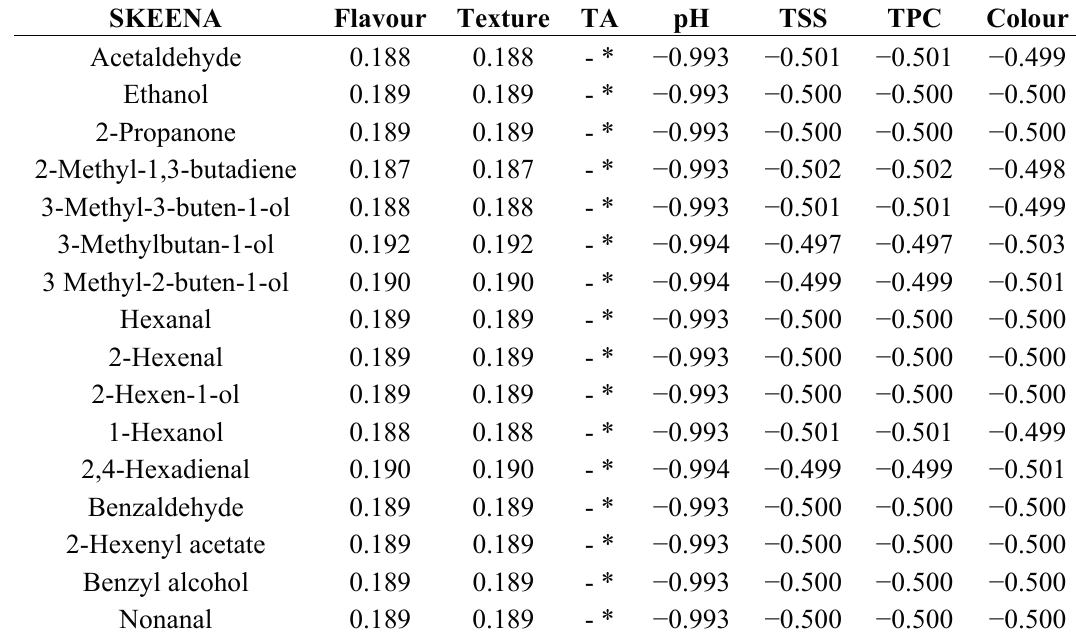
indicative however, of a very strong correlation. Table 7. Correlation between volatile compounds and physicochemical/sensory attributes in the Skeena